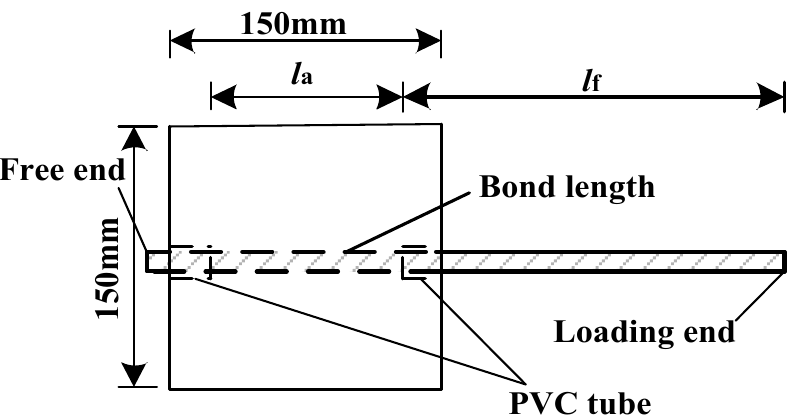
Figure 2. Sketch for pull-out test based on a cube specimen.